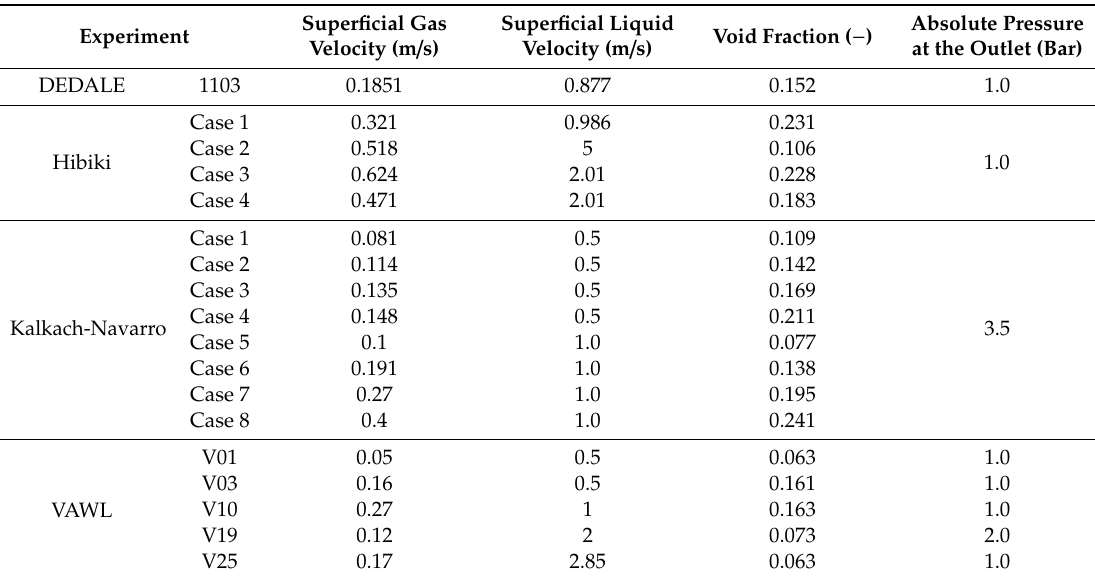
Table 4. Experimental conditions of each experiment used to